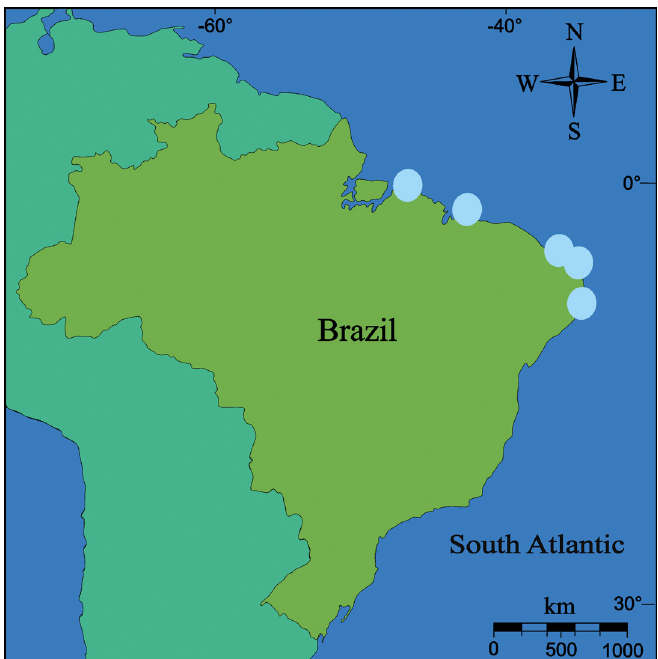
Figure 16. Distribution of Excorallana warmingii (Hansen, 1890) for Brazilian